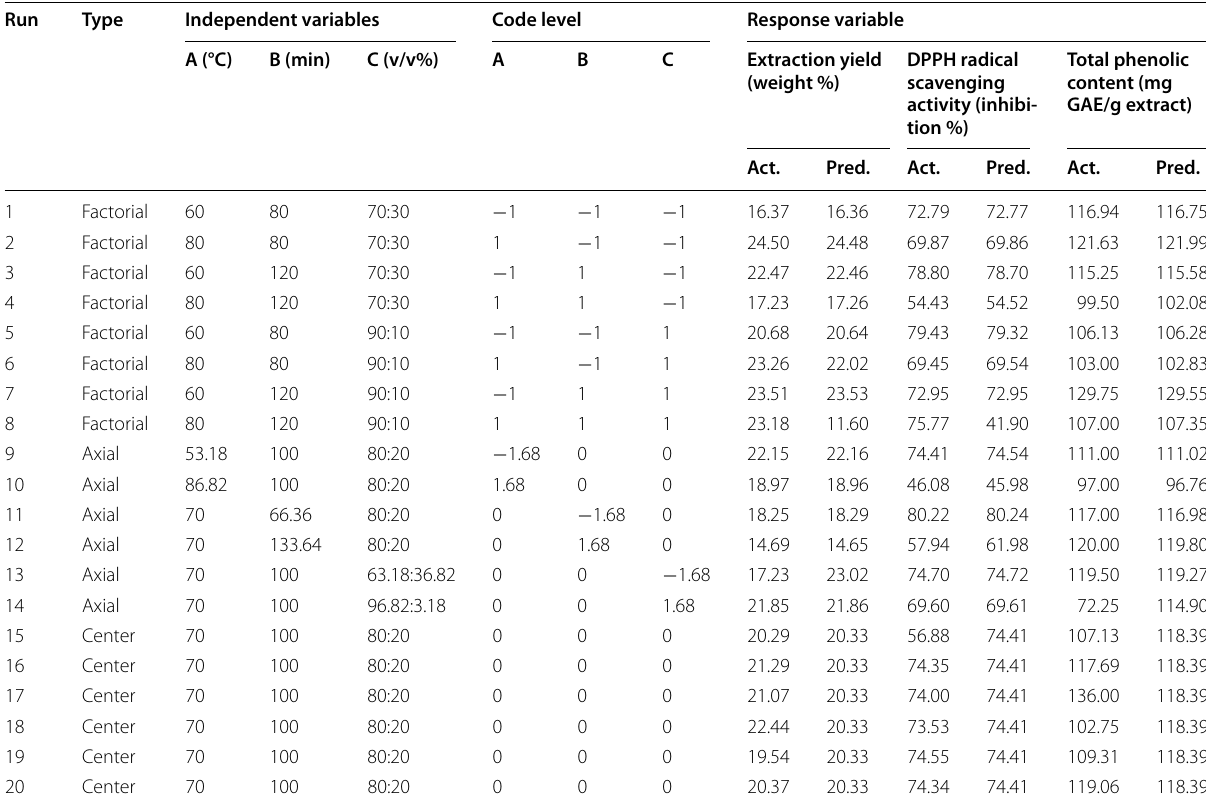
Table 2 Design matrices of actual and predicted values of extraction temperatures (A), extraction times (B) and solvent ratios (water: ethanol) (C) for the extraction conditions of C. nutans leaves using the CCRD design